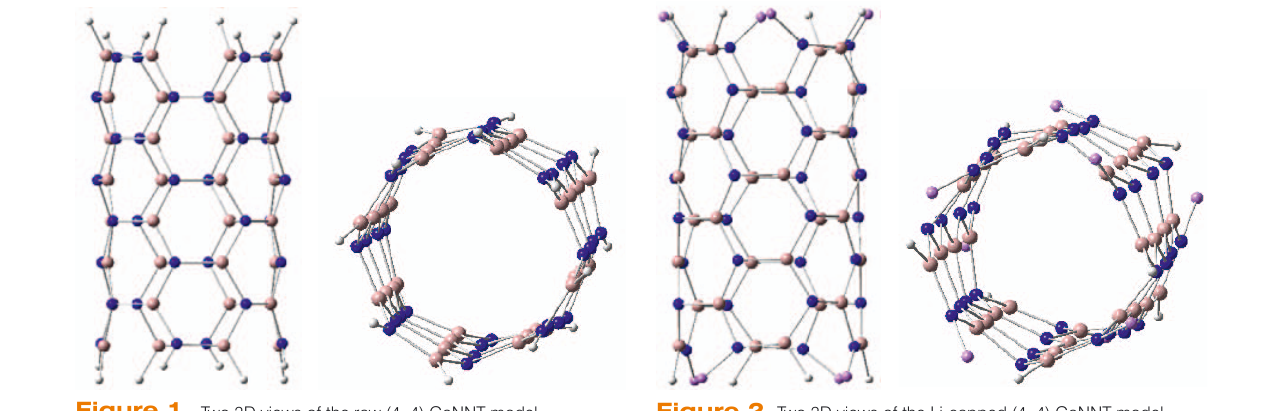
Figure 1. Two 3D views of the raw (4, 4) GaNNT model. Figure 2. Two 3D views of the Li-capped (4, 4) GaNNT model.